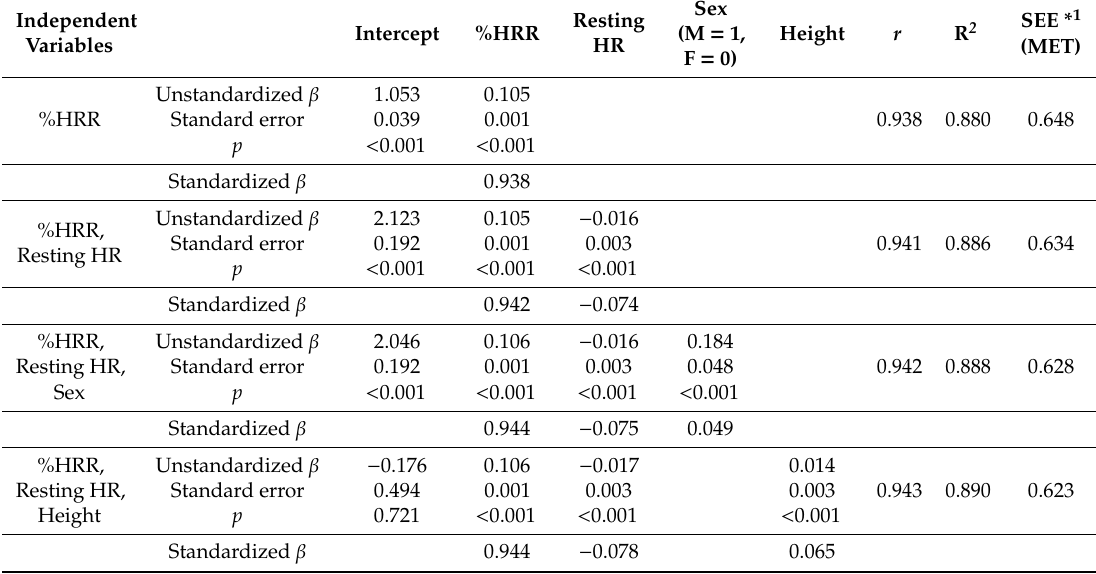
Table 5. Results of multiple regression analyses for estimating METs; model with %HRR (n =